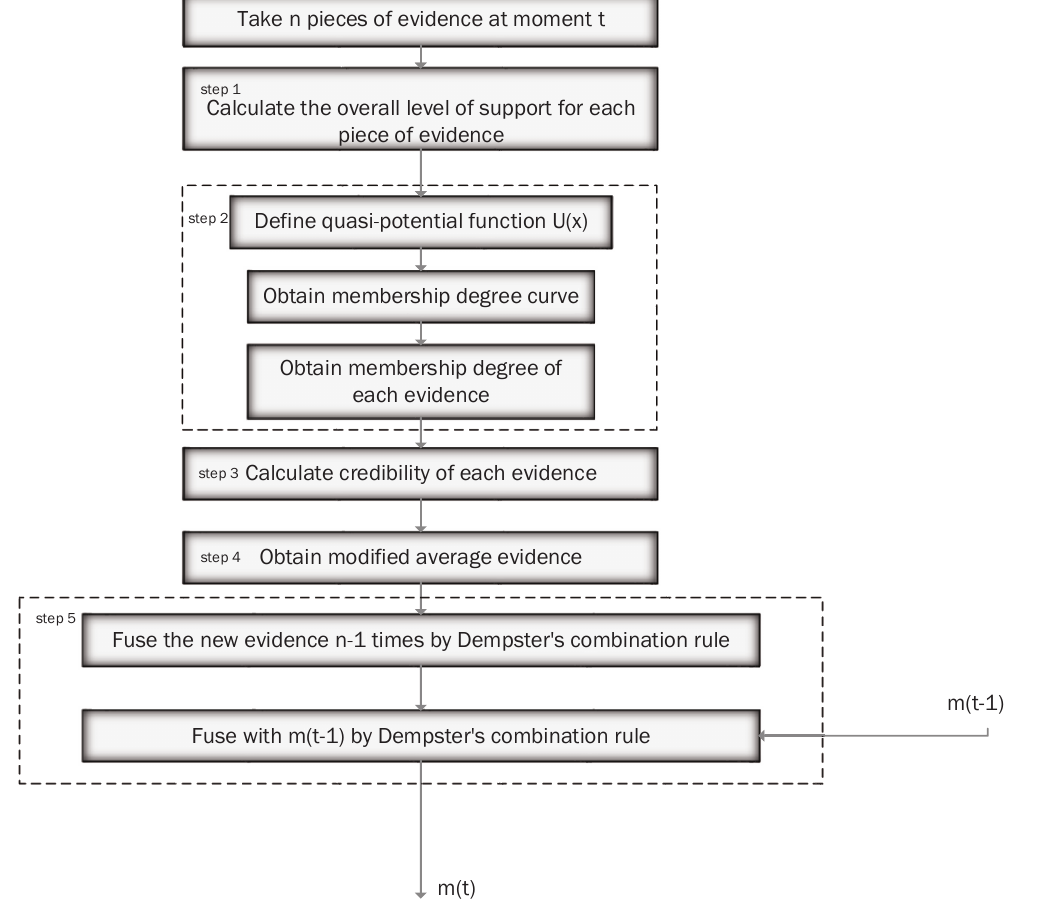
Figure 6. The process of the proposed